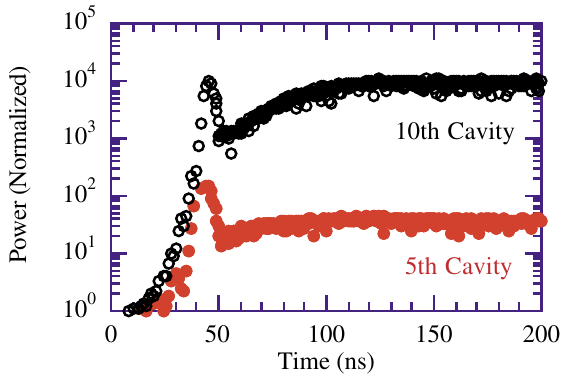
FIG. 3. (Color) Simulation of expected growth of the trans- verse instability as a function of time during the beam pulse for two different cavities. Phase advance per cavity (cid:2) 370 (cid:1) .